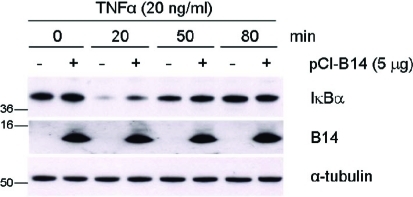
The Effect of B14 on IκBαB14 was expressed in HeLa cells by transfection and the cells were treated with TNFα for the indicated times. Then TNF was washed away and extracts were prepared and analysed by immunoblotting with the indicated Abs. Cell lysates (15 μg per lane) were resolved by SDS-PAGE (15% gel) and analysed by immunoblotting with the Abs indicated on the right. Sizes of bands detected are indicated on the left in kDa.